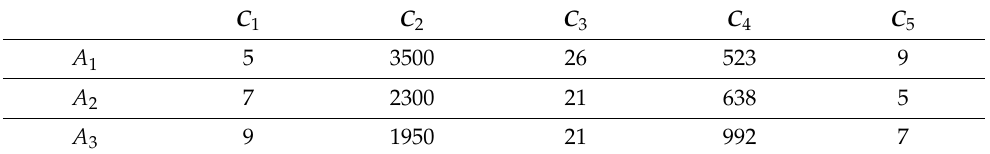
Table 1. A decision matrix with random variables.